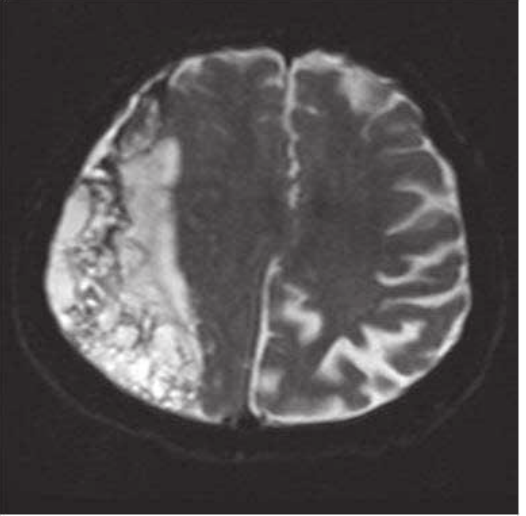
Figure 3: Axial T1-weighted MRI; Hyperintense right frontoparietal and left frontal residual chronic subdural hematoma, left arachnoid cyst.